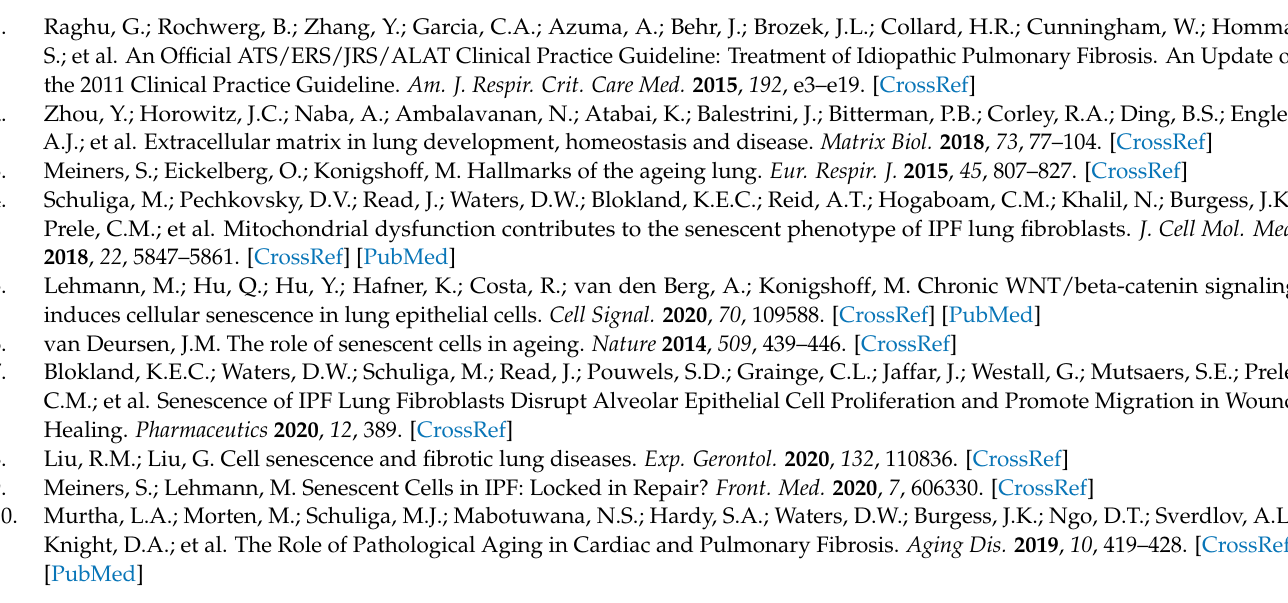
Figure S5—Fibrosis-associated and crosslink gene expression; Figure S6—SA- β -Gal-positive cells cultured on Ctrl- and IPF-derived ECM that received treatment; Figure S7—Markers of senescence in Ctrl-LFs cultured on treatment-derived ECM; Figure S8—Fibrosis-associated and crosslink gene expression; Figure S9—Fibrosis-associated gene expression and secretion of profibrotic cytokines; and Figure S10—Fibrosis-associated and crosslink gene expression. Table S1—Donor 1 Treatment Groups & Donor 2 Treatment Groups. References [43–45] are cited in the supplementary